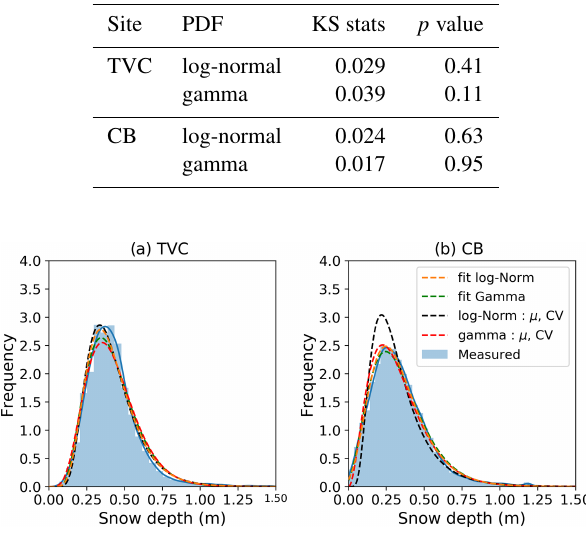
Figure 2. Log-normal and gamma distribution fit to the measured snow depths.